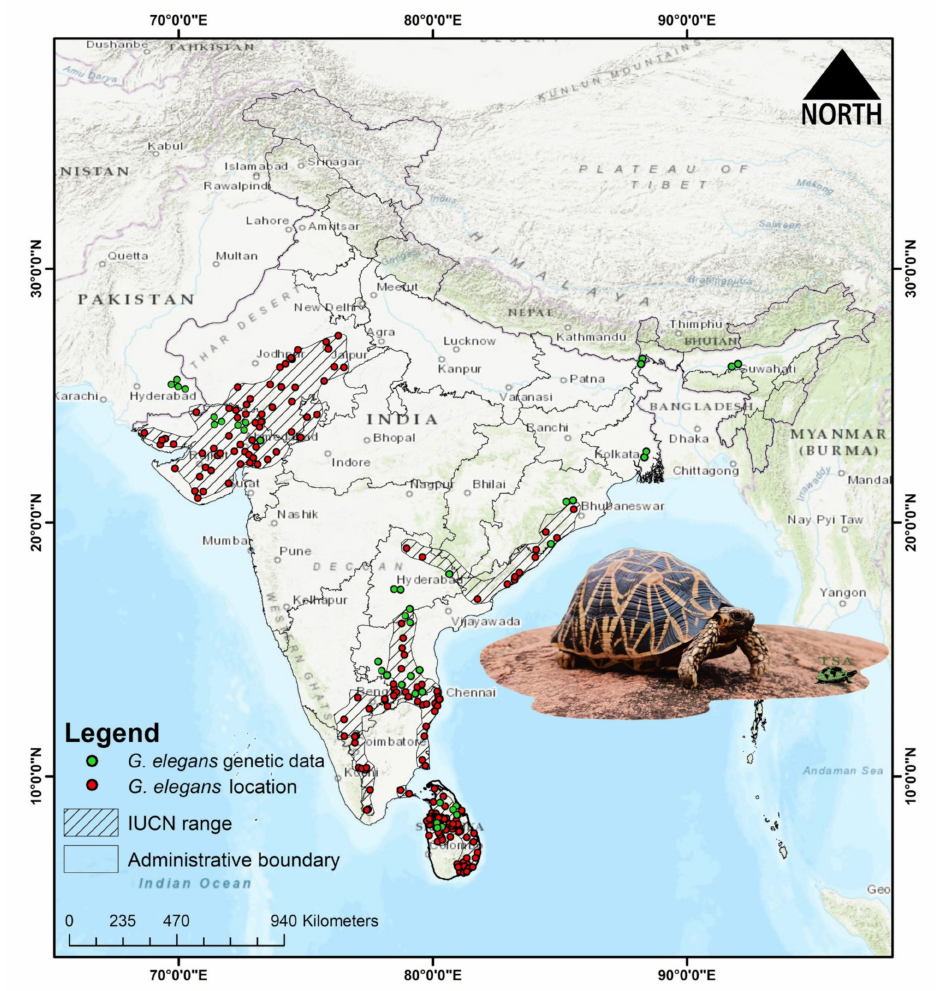
Figure 1. Map showing the distribution of Geochelone elegans . The Map is prepared in the ArcGIS 10.6 platform using polygons (shp file) from the IUCN Red List of Threatened Species, which was assessed on 13 March 2018 (IUCN version 2022-1 acquired on 22 November 2022). The known distribution and collection sites of G. elegans are marked by red dots. The locations of the G. elegans genetic data generated during the current and previous studies are marked by green dots. The species photograph was acquired from the Turtle Survival Alliance India with prior